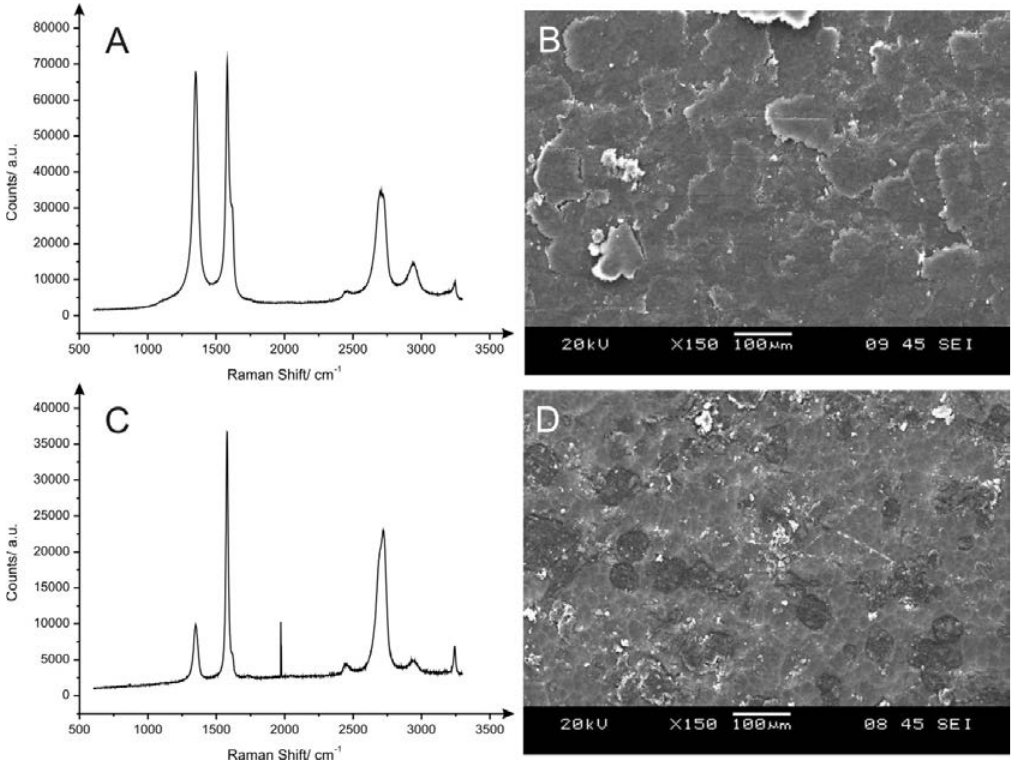
Figure S2. Raman spectra and SEM images of PDEs fabricated using HB ( A ) and ( B ) and 4B ( C ) and ( D ) pencils from Box 1.